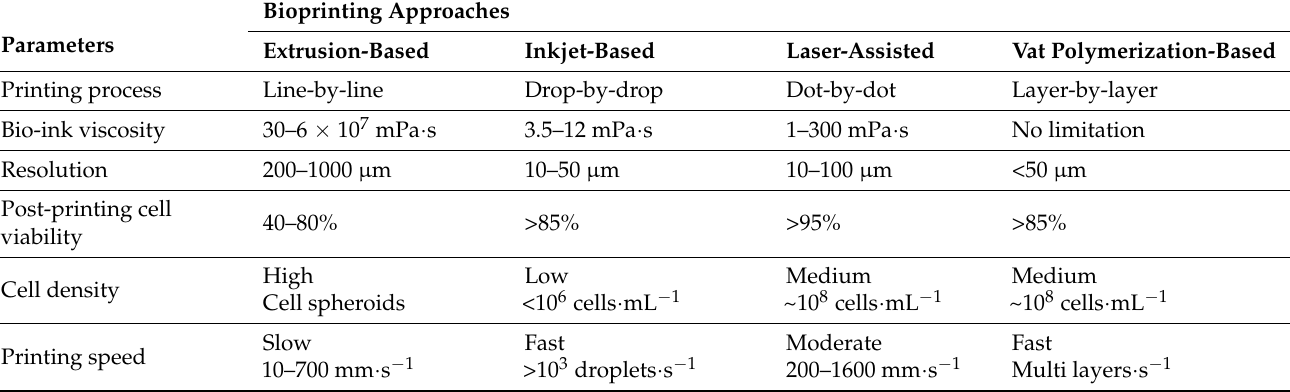
Table 2. Comparison of different bioprinting